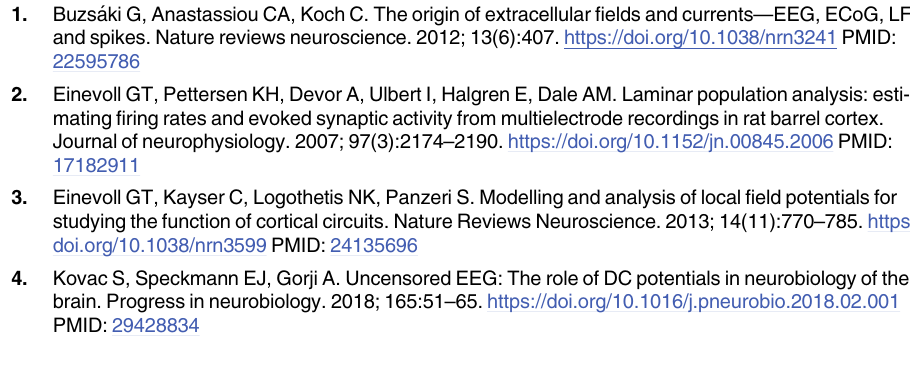
S2 Fig. Membrane currents during pathological activity. Components (various ion channels, stimulus, capacitive currents, and ion pumps) of the transmembrane current in the neural soma layer (A) , the neural dendrite layer (B) , the glial soma layer (C) , and the glial dendrite layer (D) . The current components were plotted as moving averages using a time window of 10 s. The simulation was the same as in Fig 4, where the neuron was driven into depolarization block. (A) At the end (and throughout most) of the simulation, the neuronal membrane cur- rent in the soma-layer was primarily composed of an (outward) Na + current, and the (inward) delayed rectifying K + current and pump current. The Na + current was largest in magnitude, but smaller than the sum of the two inward currents, so that the soma was a net current source. (B) At the end of the simulation, the neuronal membrane current (sink) in the dendrite layer was dominated by the (inward) Ca 2+ current. (C) The glial membrane currents were domi- nated by the leak current (sink) in the soma-layer and (D) the Kir current (source) in the den-